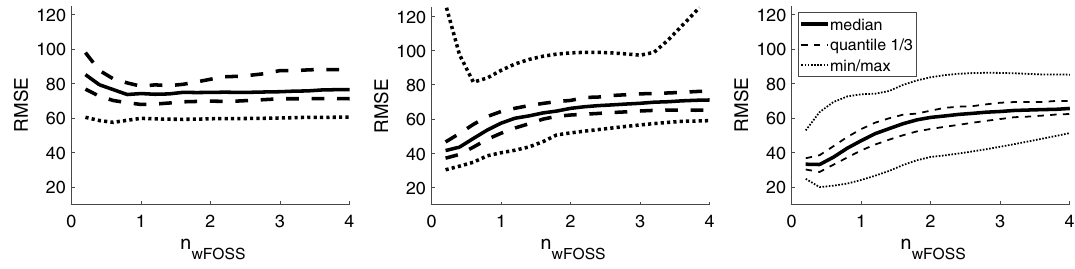
Fig. 6 Branin function: Curves of the RMSE of 100 FOSS sampling plans as a function of the FOSS exponent n wFOSS for the DACE model with 4 (left), 9 (center), and 16 (right) sampling points